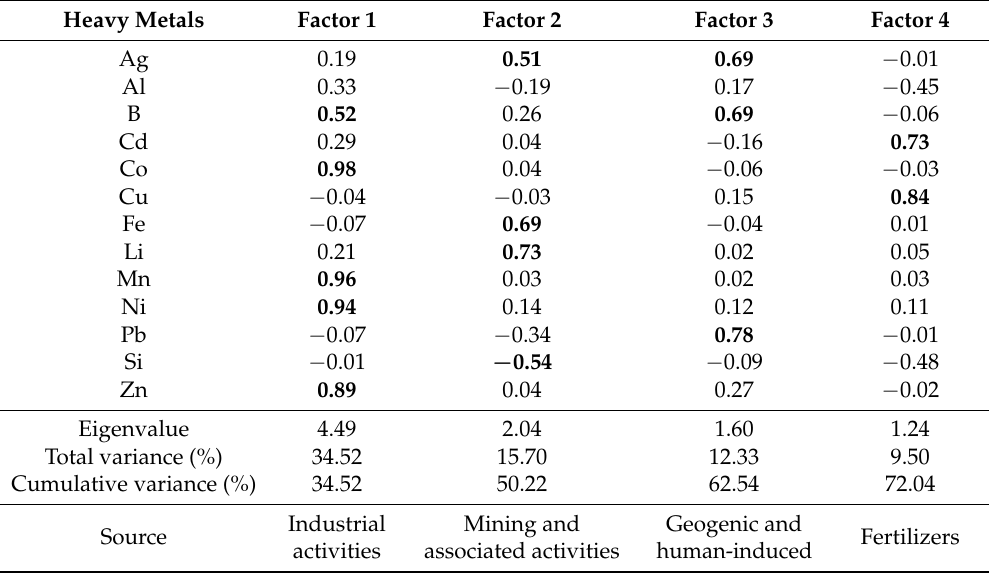
Table 9. Factor analysis of heavy metals in